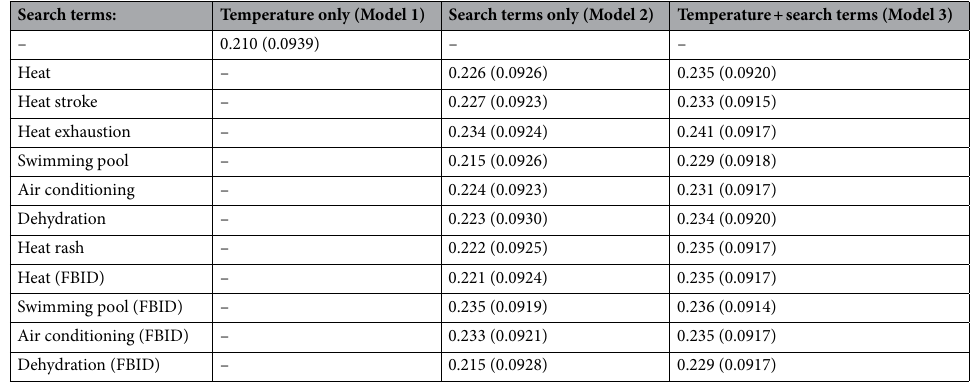
Table 1. Model comparison with median pseudo-R square 1 (mean square error 2 ). FBID freebase identifier. 1 The median of pseudo-R squared across 30 DMAs. 2 The mean of mean square error across 30